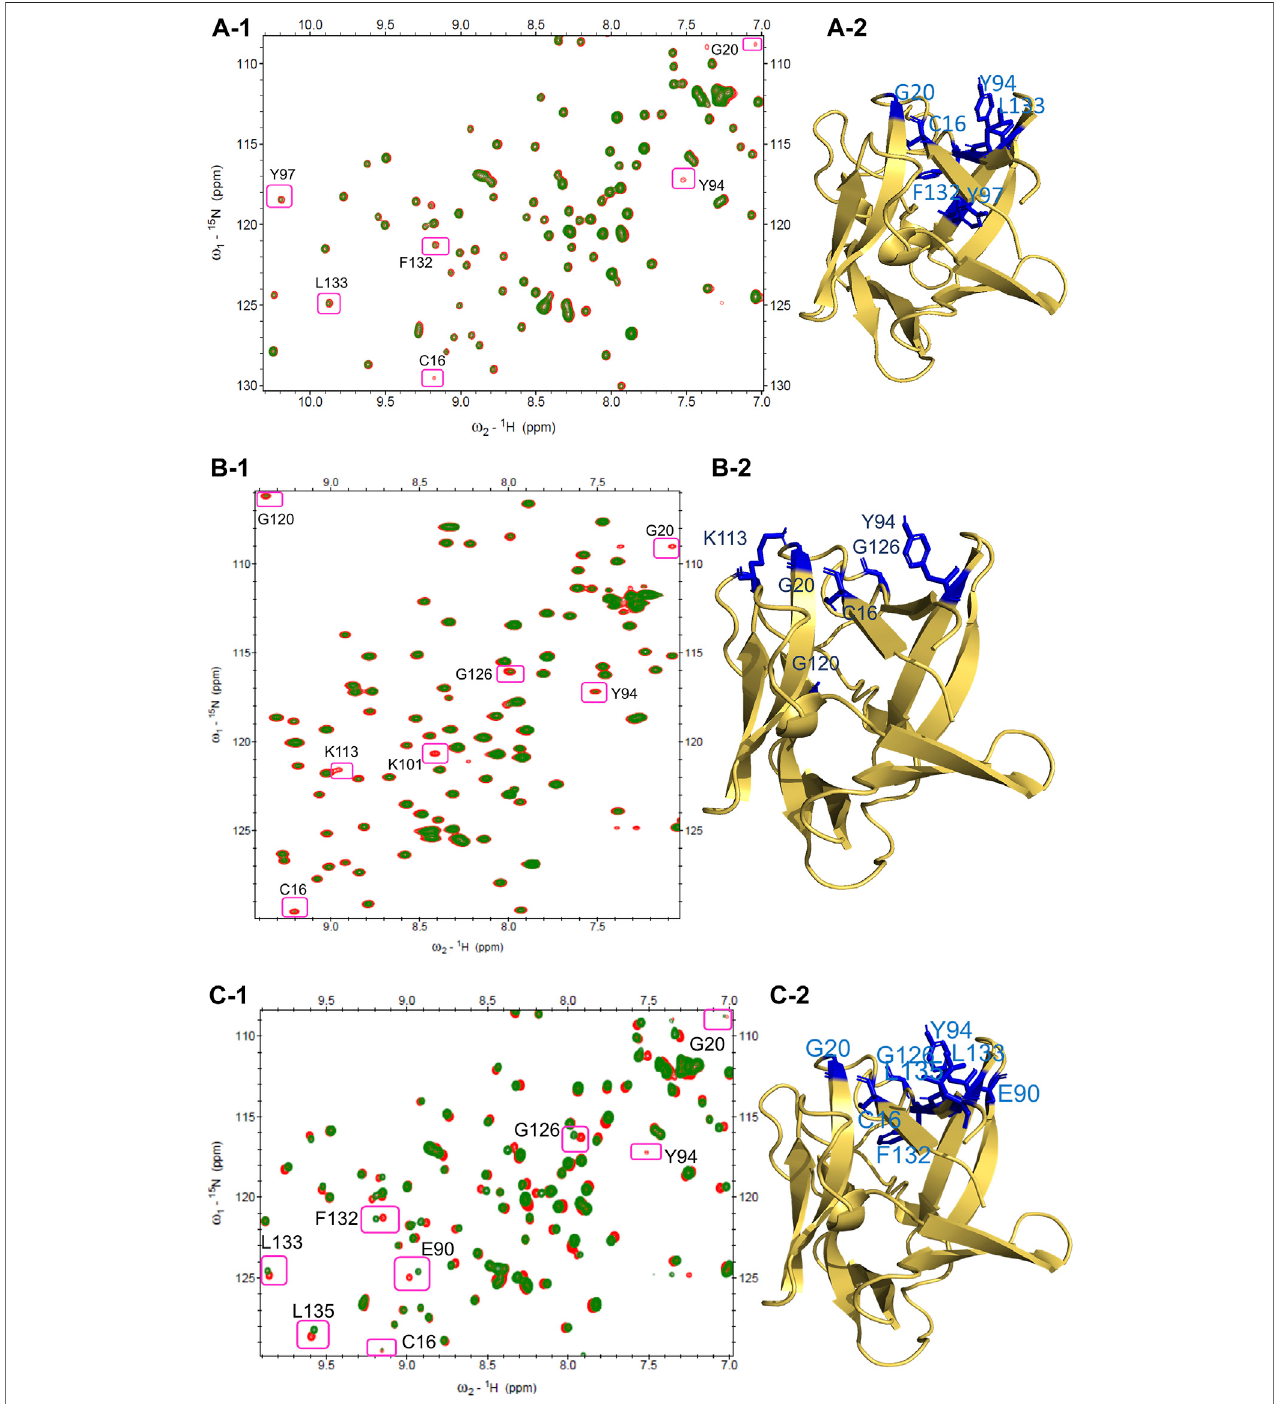
FIGURE2| HSQCSpectraoffreeFGF1(red)overlappedwithdifferentcompoundsto1:1ratio(green): (A-1) HSQCspectrumshowingpeakintensitydecreaseand some peak disappearances upon additionof compound 14 . (A-2) Residues that shows peak intensity decrease or disappeared are highlighted inblue (side-chain) in the illustration of cartoon form of FGF1. (B-1) HSQC spectrum showing peak intensity decrease and some peak disappearances by compound 15 . (B-2) Residues that showing decreased peak intensity or disappeared are highlighted in blue (side-chain) in the illustration of cartoon form of FGF1. (C-1) HSQC spectrum showing perturbationandpeakdisappearancebycompound 17 (green). (C-2) Residuesthatwereperturbedordisappearedarehighlightedinblue(side-chain)intheillustrationof cartoon form of FGF1. (D-1) HSQC spectrum displaying peak intensity decrease and peak disappearance by compound 18 . (D-2) Residues that decrease in their peak intensity or disappeared are highlighted inblue (side-chain) inthe illustration ofcartoon form ofFGF1. (E-1) HSQC spectrumdisplayingpeak intensity decrease and peak disappearance by compound 21 . (E-2) Residues showing peak intensity decrease or disappeared are highlighted in blue (side-chain) in the illustration of cartoon form of